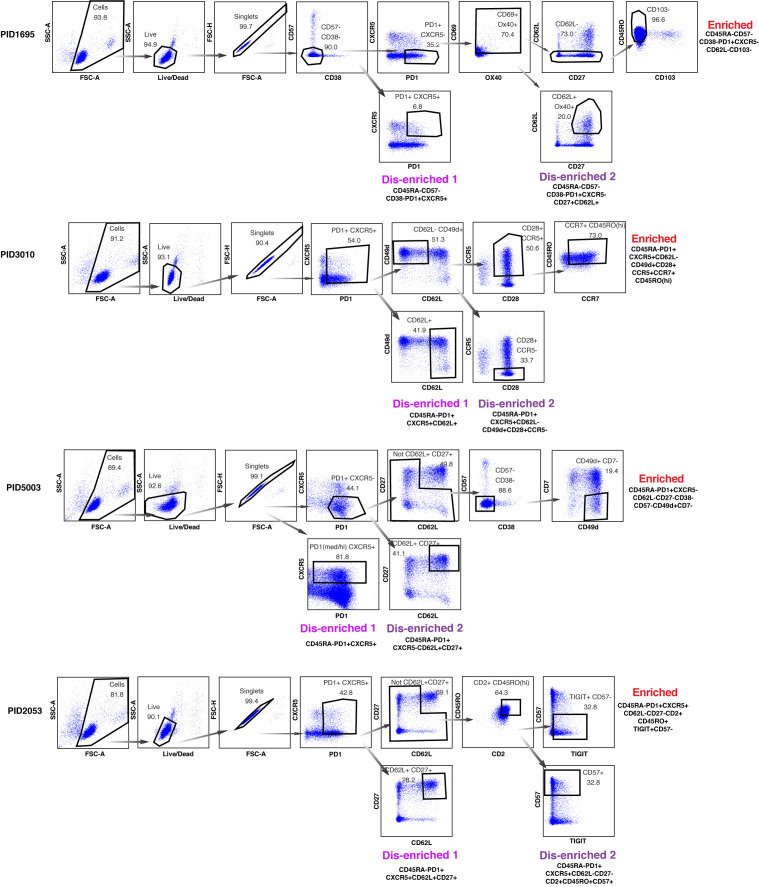
Implementation of tailored sort strategies to isolate three populations of memory CD4+ PD1+ T cells harboring different frequencies of kNN latent cells.The sorting strategies described in Figure 5 were converted into multiparameter flow panels and used to isolate the three populations of memory CD4+ PD1+ cells for each of the four donors as shown. Shown are FACS plots from the sorts. Memory CD4+ T cells from each donor were purified by negative selection before sorting. The phenotypic features of each sorted population are depicted beneath the corresponding population.